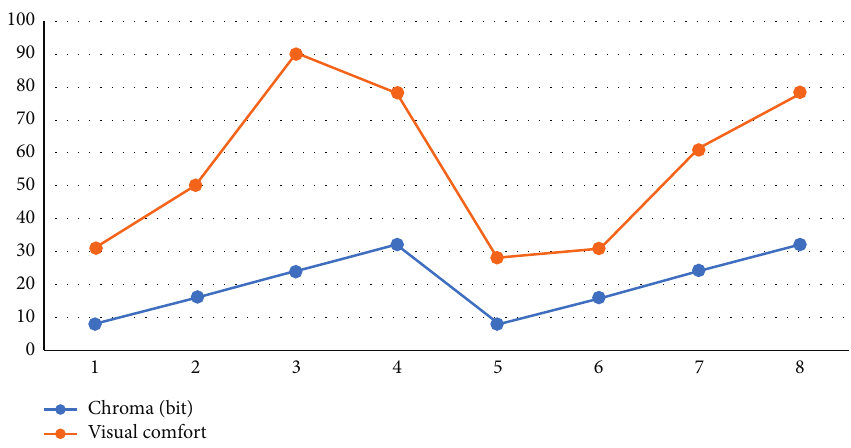
Figure 2: Color environment in general interior conditions.